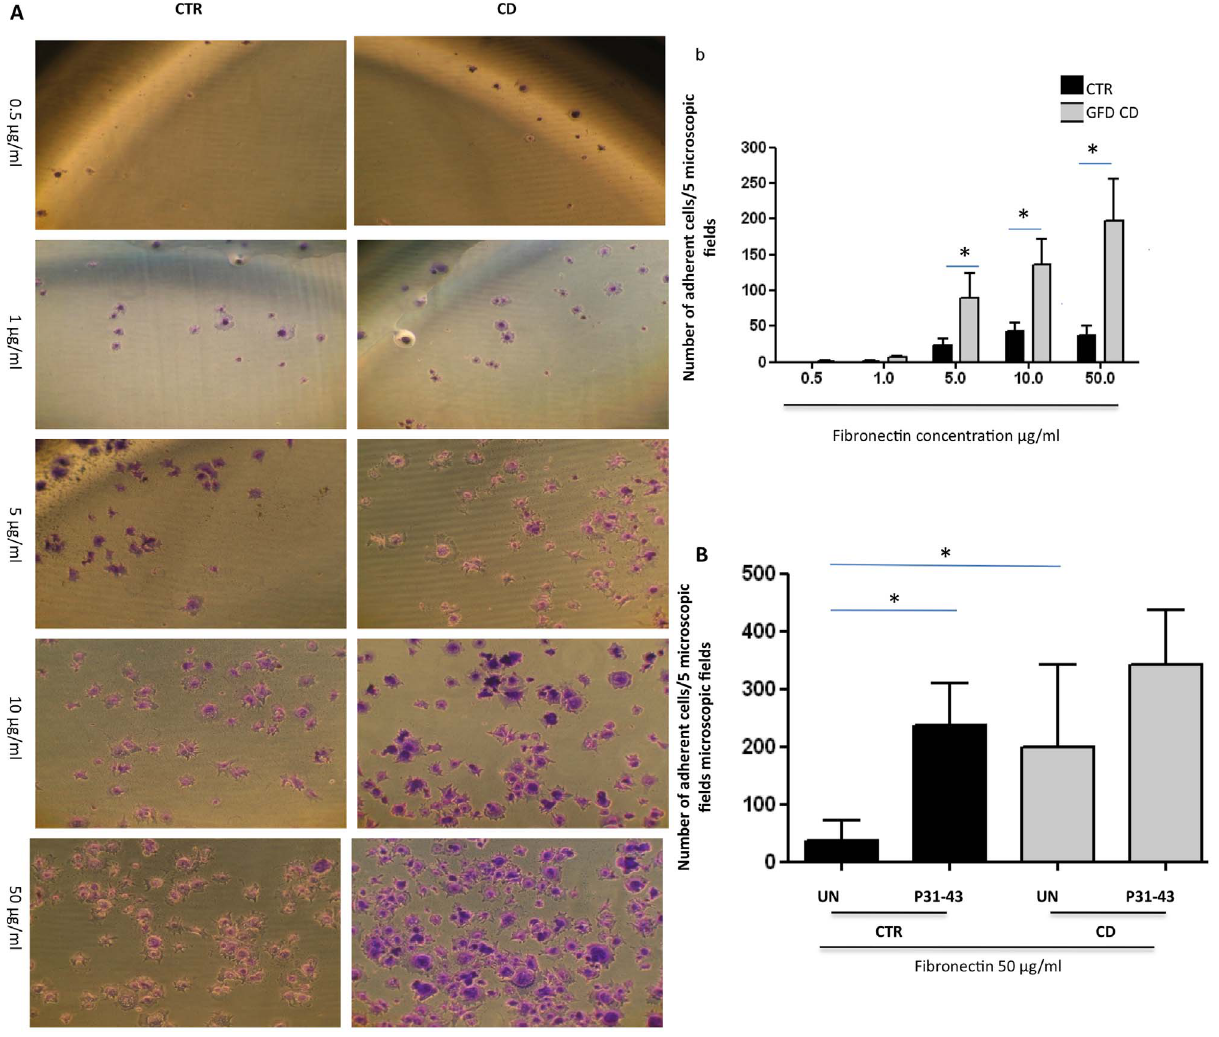
Figure 5. Fibronectin adhesion of CD fibroblasts respect to controls. A. CD fibroblasts adhered more than controls to fibronectin. a) Transmitted light images of crystal violet stained fibroblasts from CD patients and controls, seeded for 1 h on increasing concentrations of fibronectin, as indicated. Representative fields. b) Statistical analysis of the number of adherent fibroblasts from CD patients and controls seeded on different concentrations of fibronectin, as indicated. For each fibronectin concentration, the fibroblasts of 5 fields from 3 independent experiments with 5 patients and 5 controls were counted. Columns represent the means, and the bars represent the standard deviations. Student’s t -test. *= p , 0.01. B. P31-43 increased adhesion to fibronectin. Statistical analysis of the number of adherent fibroblasts from CD patients and controls seeded on 50 m g of fibronectin after P31-43 treatment for 1 h. Fibroblasts in 5 fields from 3 independent experiments with 5 patients and 5 controls were counted. Columns represent the means, and the bars represent the standard deviations. Student’s t -test.